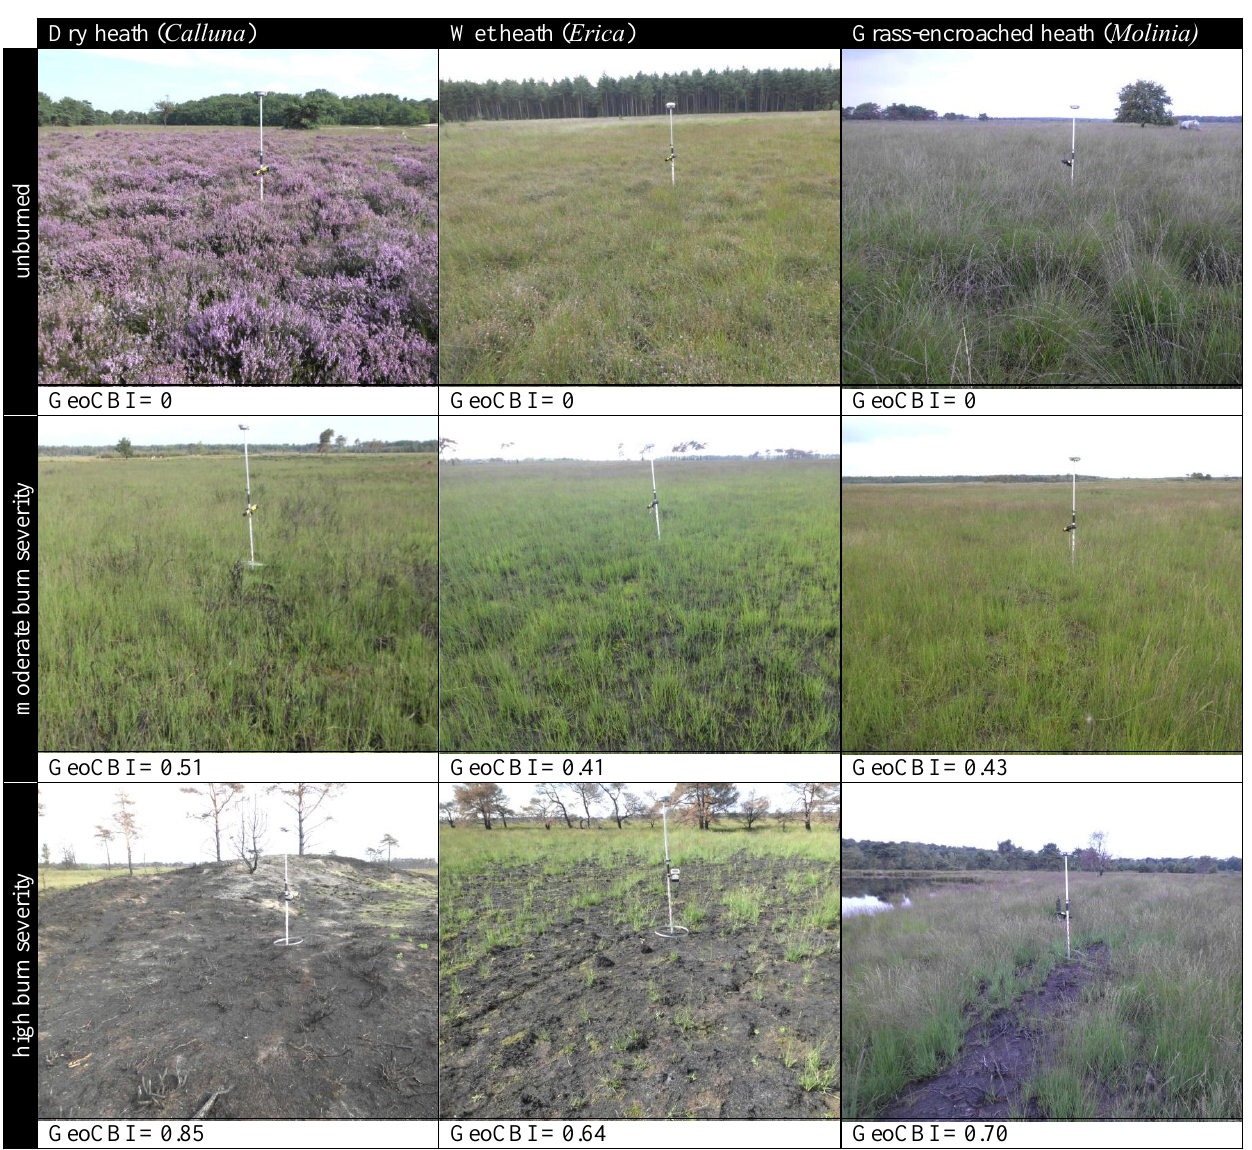
Figure 3. Example photographs and modified GeoCBI score (under each photograph) of dry ( Left ) and wet heath ( Middle ) and grass-encroached heath ( Right ) with different burn severity. (0 is unburned, while 1 represents highest